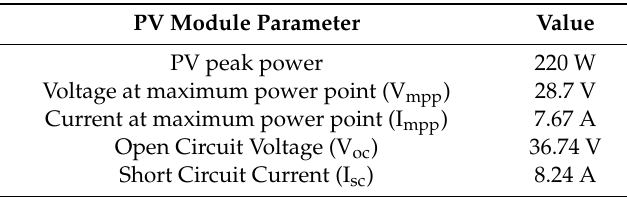
Table 2. PV Module Electrical